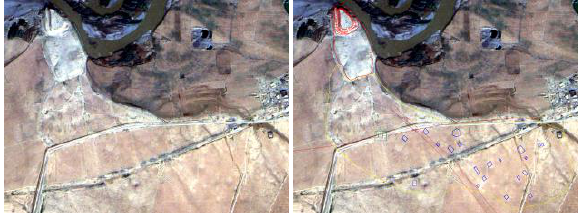
Figure 17a, b - Kushaf - a RGB synthesis of the FORMOSAT-2 images (acquired on 24.10.2014) with overlaid objects of interest on the left picture